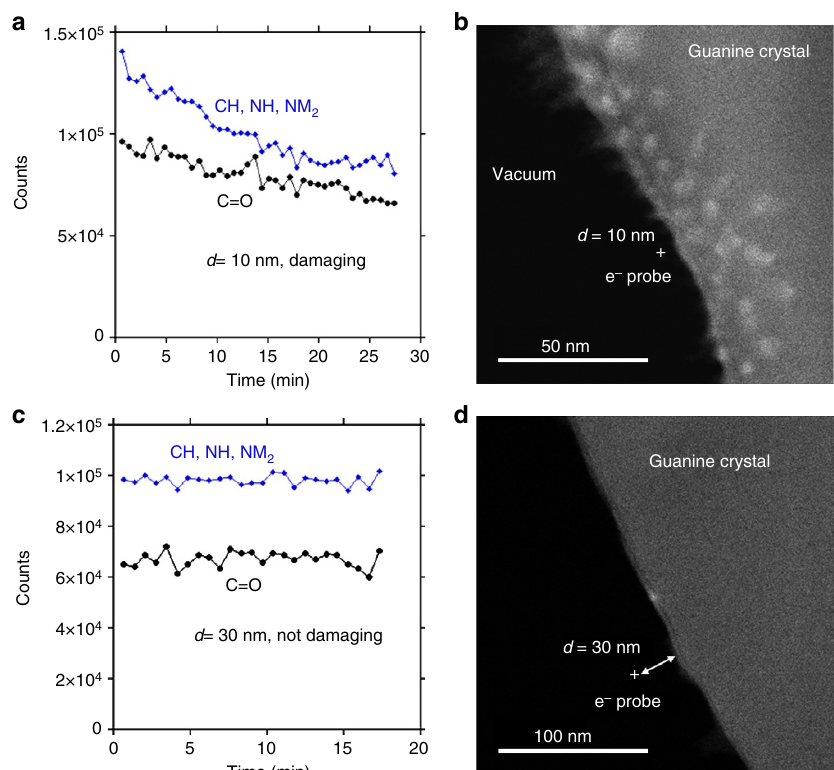
Figure 4 | Time dependence of infrared region peaks. The time dependence of the C ¼ O peak height and the integrated peak area from the hydrogen- stretching modes for an electron probe placed ( a ) 10nm from the edge of the specimen and ( c ) 30nm from the edge of the specimen. Images taken after acquiring the data in a , c are shown in b , d , respectively. Note the visible signs of damage when the probe was positioned 10nm from the edge of the specimen, in contrast to the absence of damage when the probe was at a distance of 30nm. Also note that damage is present at distances greater than would be expected from the ‘delocalization’ of the probe g v o